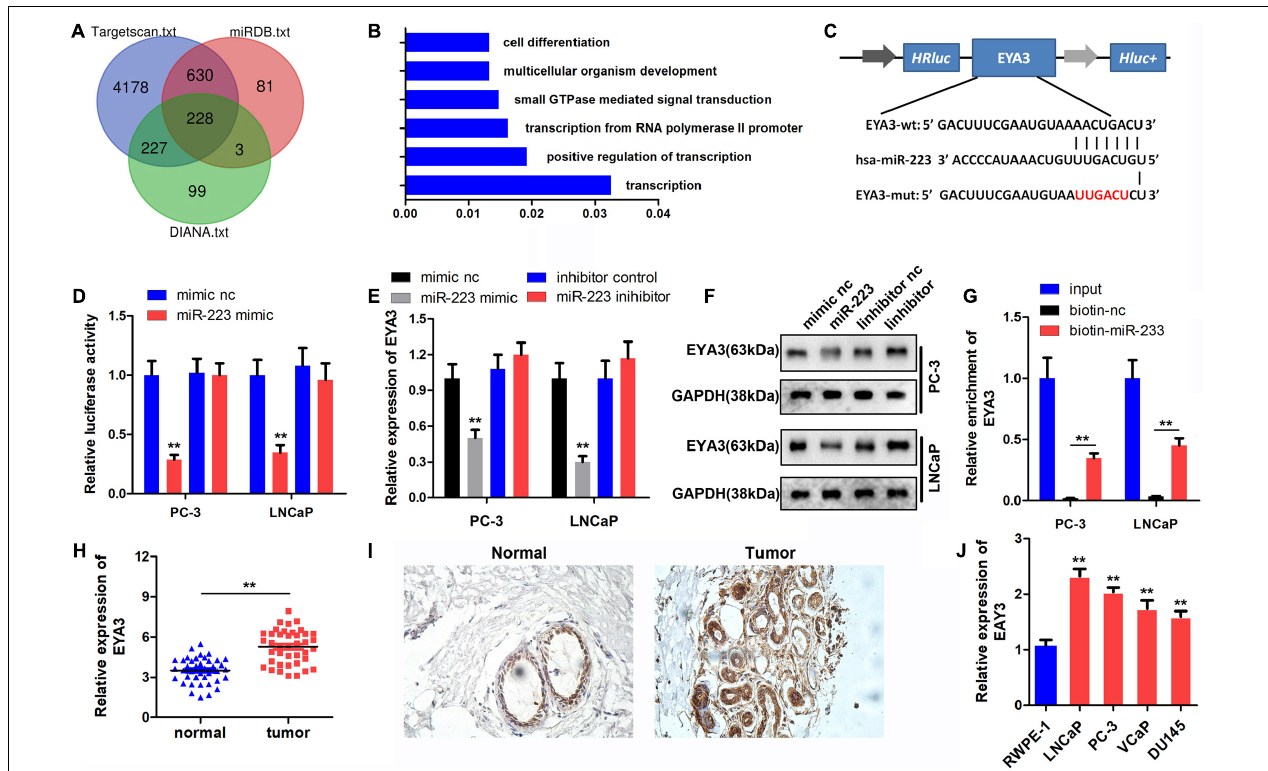
FIGURE 4 | Targeted binding of miR-223 to EYA3. (A) TargetScan, miRDB and DIANA databases were used to predict the target of miR-223 and the target genes were intersected. (B) Functional enrichment analysis of target genes. (C) The binding sites and mutations of miR-223 and EYA3 are shown. (D) Dual luciferase reporter assay confirmed the binding between miR-223 and EYA3. (E,F) Western blot was performed to detect the expression of EYA3 after the overexpression or knockdown of miR-223. (G) RNA pull-down assay verified the binding between miR-223and EYA3. (H,I) Analysis of EYA3 expression in prostate cancer tissues using qPCR and immunohistochemistry. (J) Expression of EYA3 in prostate cancer lines was detected by qPCR. ** p < 0.01 vs. mimic NC and RWPE-1 group. miR, microRNA; EYA3, eyes absent homolog 3; qPCR, quantitative PCR; NC, negative